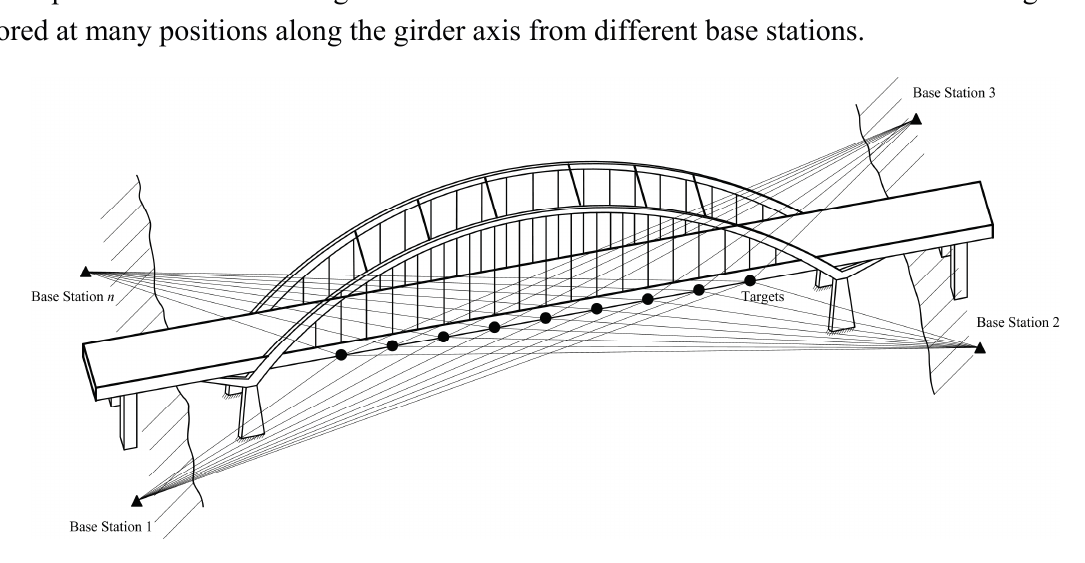
Figure 1. Displacement monitoring scheme of an